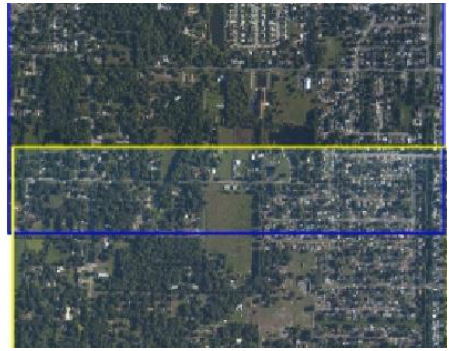
Figure 5. Images before color matching